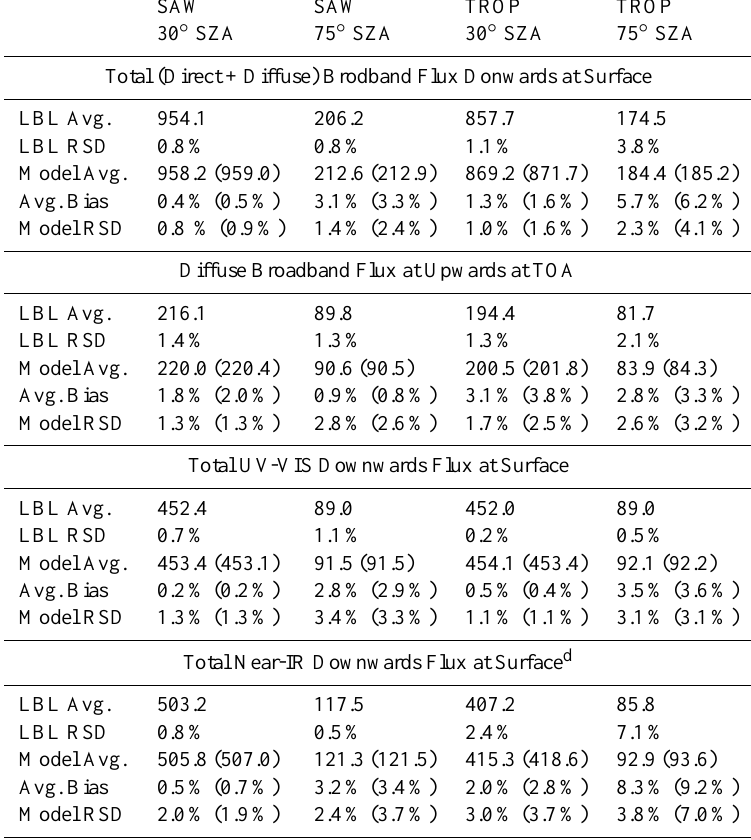
Table A4. Case 2b: summary of statistics for absorbing serosols a , b , c